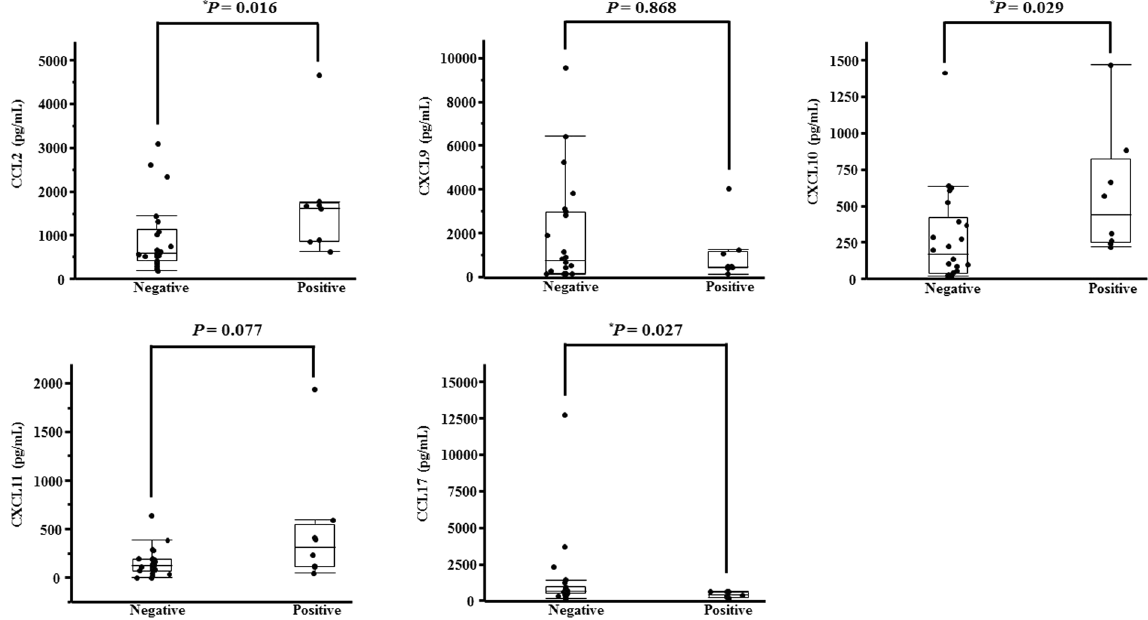
Figure 3. Comparison of each of the chemokine levels between anti-MDA5 antibody-positive and -negative cases. CCL: C-C motif chemokine ligand; CXCL: C-X-C motif chemokine ligand; negative: anti-MDA5 antibody-negative patients; positive: anti-MDA5 antibody-positive patients. The P value was estimated by the Mann-Whitney U-test. * P <